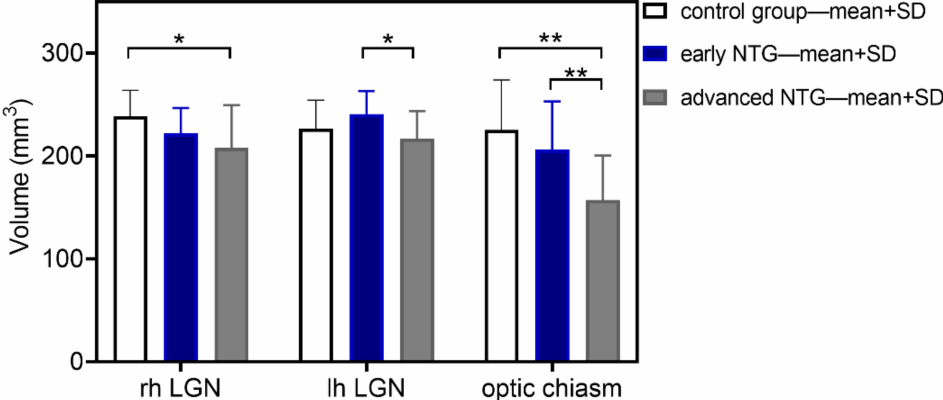
Figure 1. Results of voxel-based morphometry analysis of LGN and optic chiasm volume in studied groups: control (white), early (blue), and advanced (grey) NTG (* p < 0.05, ** p < 0.01).